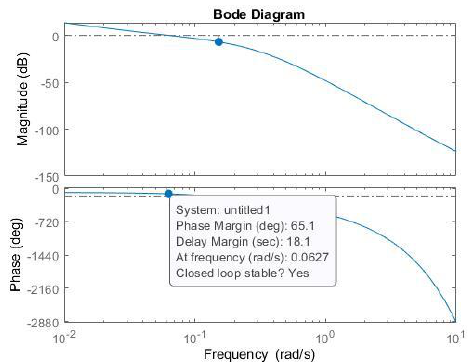
Figure 11. Bode diagram of the open-loop system for the second designed FO-PID controller.